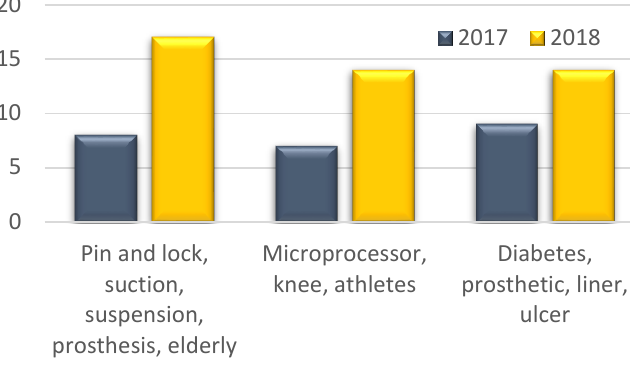
Figure 1: Number of freely accessible research papers for three searches at